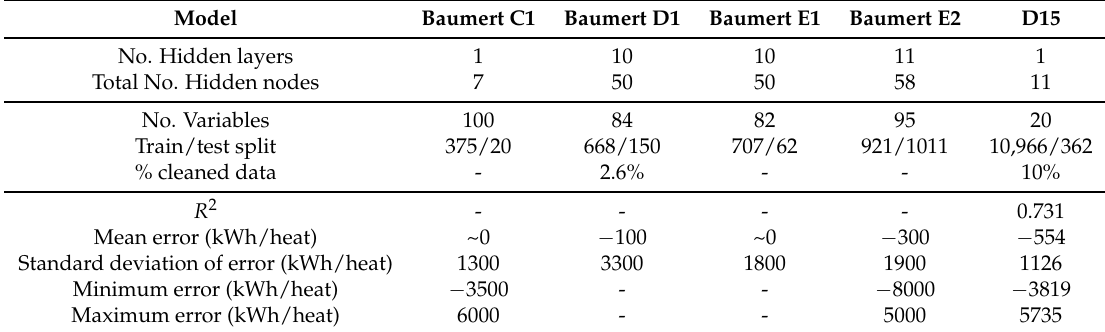
Table 11. The best model compared with ANN models created by Baumert et al. [21–23]. Only models that were tested on test data and presented the number of test heats are reported. Dashed entries indicate missing